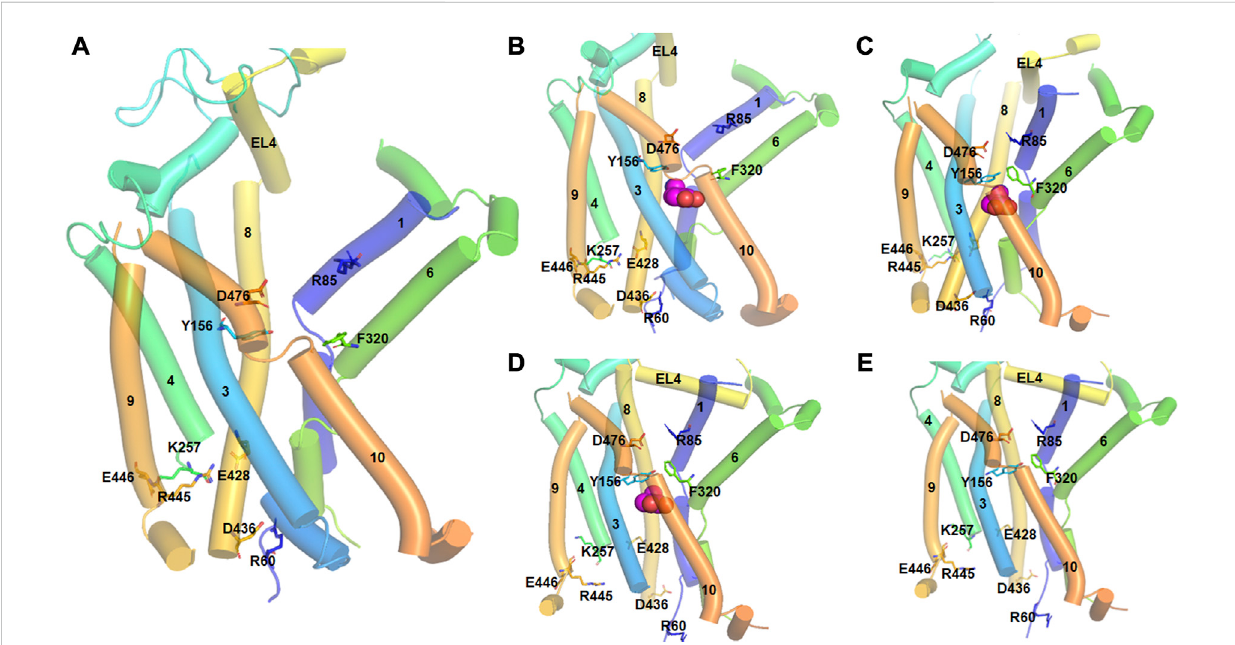
FIGURE 2 Different conformational states of hDAT during the transport cycle. The TM helices are numbered and represented by tubes. Important residues involvedinconformationalchangesareshowninstickmodelandlabeled.Substratemolecule(DA)isrepresentedinsphericalmodel. (A) .Intheoutward- openstate(apoform),thesaltbridgebetweenD476(TM10)andR85(TM1)whichactsasthe fi rstextracellulargateisinterrupted.Similarly,theinteraction between Y156 and F320 which function as the second extracellular gate is also broken. At the intracellular side, there are strong ionic interactions betweenE448-K257,R445-E428andD436-R60residues.Particularly,D436-R60actsastheintracellulargatekeeper. (B) .Intheoutward-opensubstrate bound state, a DA molecule binds at the orthostatic binding site. All the ionic interactions are the same as in the apo form. (C) . In the substrate-occluded state, theextracellular gates, D476-R85and Y156 and F320 are closed. There isalso movement of the EL4loop to close the extracellular vestibule. (D) . In theinward-openstate,theionicinteractionsE448-K257,R445-E428areinterrupted,andtheintracellulargateformedbyD436-R60isopened. (E) .Inthe inward-open state (apo from), DA is released into the intracellular sites and the cycle is